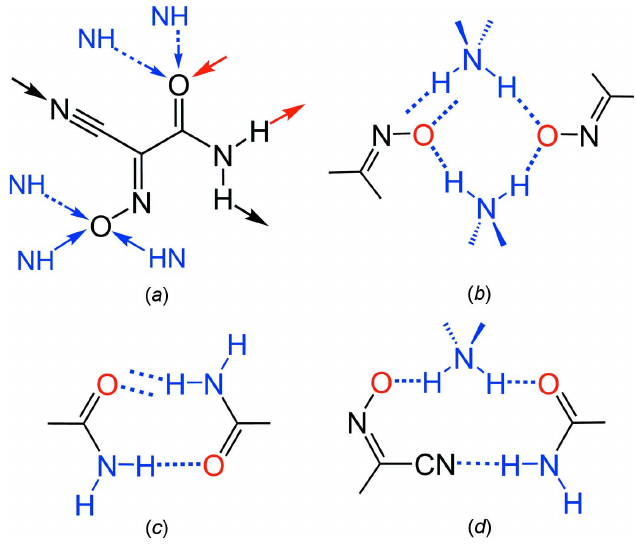
Figure 5 The hydrogen-bonding capacity of the (nccm) (cid:3) anion. ( a ) Two kinds of mutual interactions marked in black and red and bonding with NH 4+ cations marked in blue; ( b – d ) three types of supramolecular synthons identified for the the title compound taking into account a set of strongest interactions: ammonium/nitroso chain ( b ), amide/amide chains ( c ) and mutual amide/nitrile bonding ( d